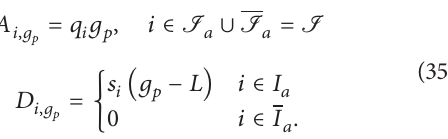
where vectors 𝛼 𝑝 and v 𝑖 are defined in (15) and (31) , respectively, the green times chosen as 𝑔 𝑝 (𝑘) = K 𝑝 x (𝑘) , 𝑝 ∈ P , can guarantee the nonaccumulative performance of the closed loop system (9)